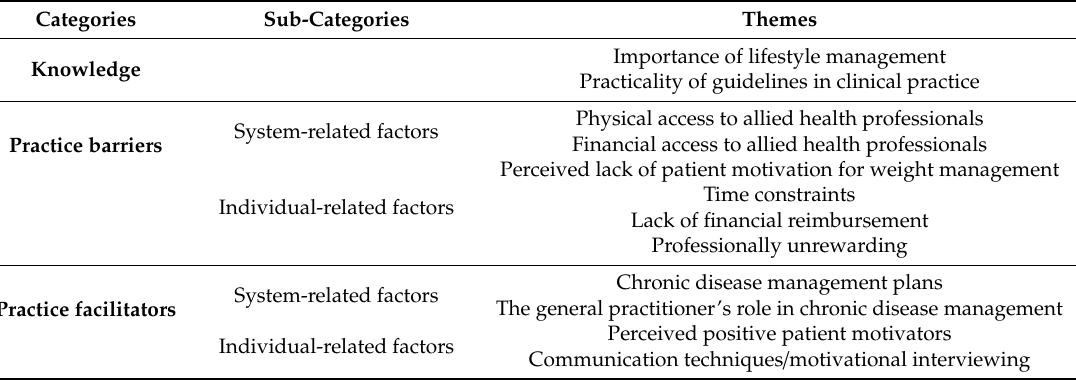
Table 2. Facilitators and barriers on knowledge and practice in lifestyle management of PCOS by GPs.